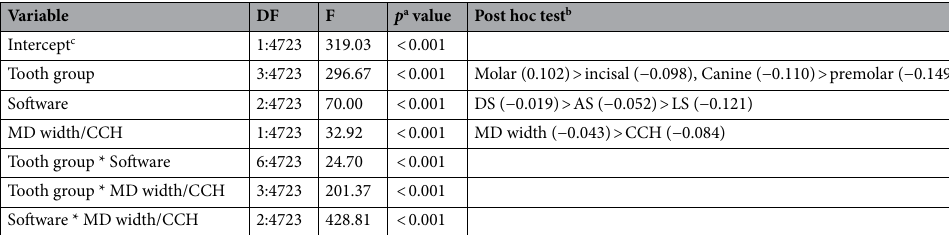
Table 6. Statistical analysis of main effects and first-order interactions affecting measurement error using GLMM. The tooth size errors were statistically different ( p < 0.001) depending on the software used, and the post hoc test showed that DS (−0.019) > AS (−0.052) > LS (−0.121). DF degrees of freedom. F F value. a p values were derived from a generalised linear mixed model. b Category (estimated mean) was presented for Bonferroni’s corrected post hoc test. c Intercept represents the mean value of the response variable when all predictor variables in the model are zero.